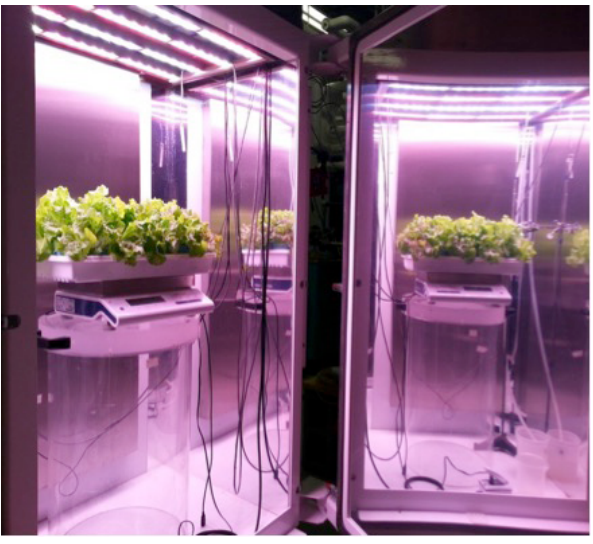
Figure 5: The Guelph PS1000 advanced analytical plant growth chamber. The combined advanced environmental manipulation, control, and physiological (e.g., photosynthesis, gas exchange, etc.)